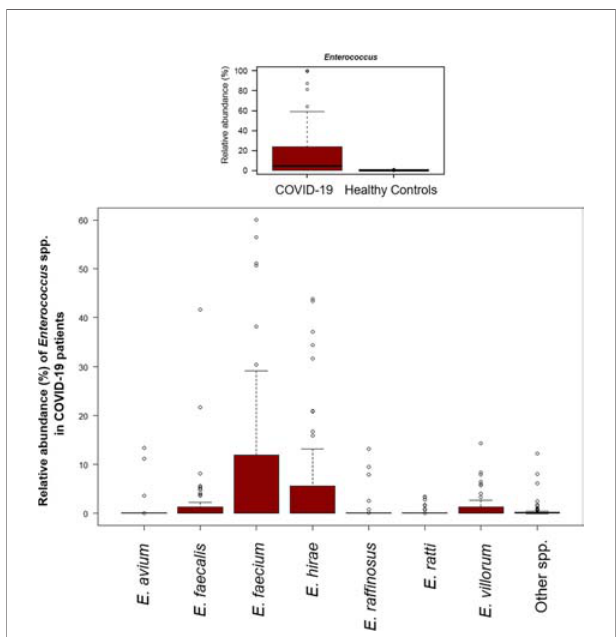
FIGURE 3 | The gut microbial ecosystem of COVID-19 patients is enriched in Enterococcus spp. Boxplots showing the relative abundance distribution of the genus Enterococcus (upper panel) and its species (lower panel) in COVID- 19 patients. Compared to healthy subjects, COVID-19 patients showed a signi fi cant overabundance of Enterococcus (p value ≤ 0.02, Wilcoxon